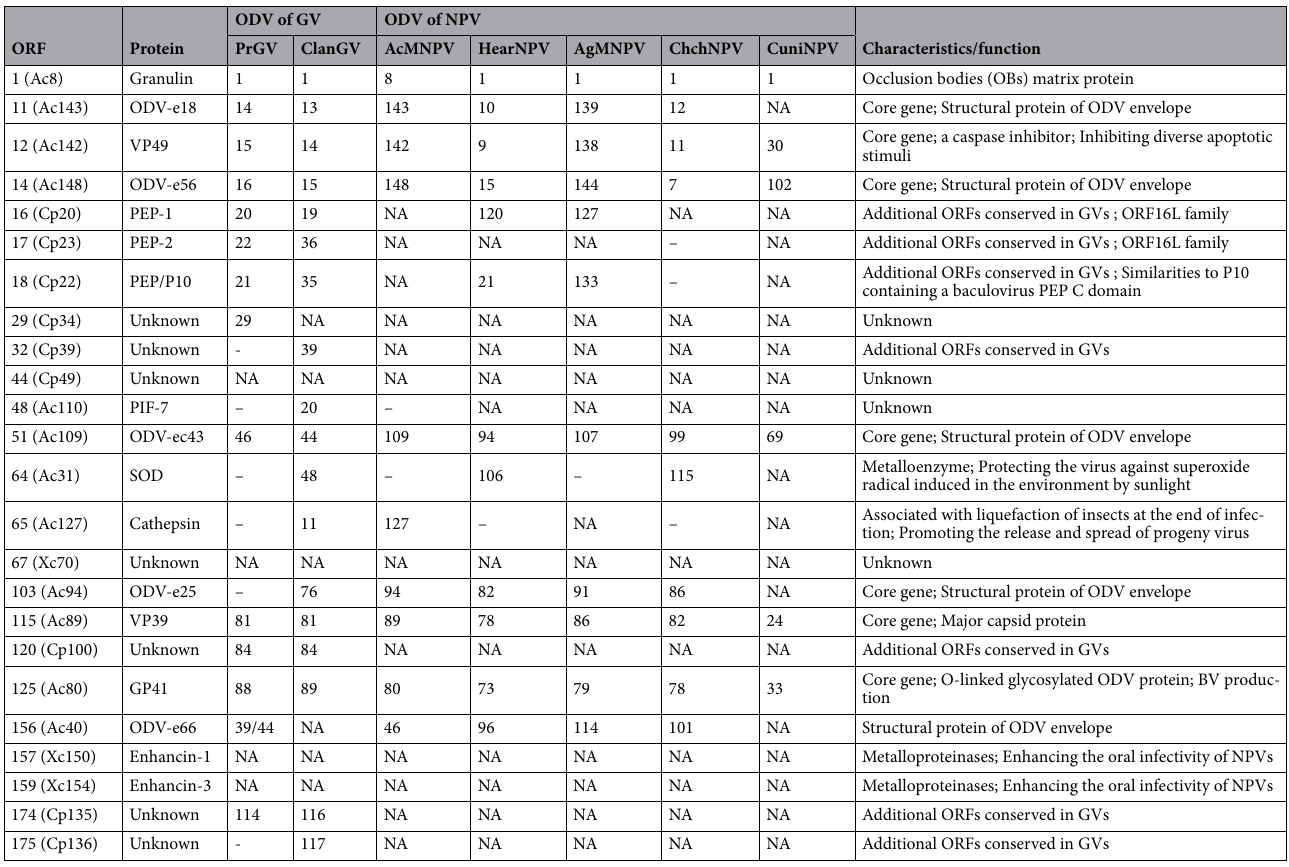
Table 2. Analysis of proteins identified from MyunGV-A. Dash (–), the protein was not detected. NA, ORF was not found in the baculovirus genome by